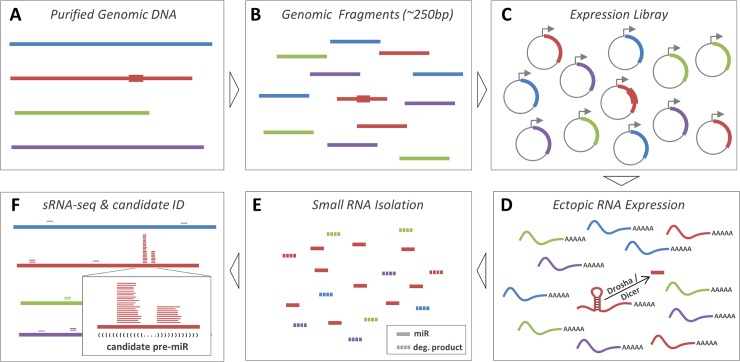
Overview of the miDGE (miRNA discovery by forced genomic expression) methodology.(A) Pools of purified viral genomes are subjected to (B) fragmentation via sonication or limited digest (average target size of fragments approx. 250 bp), followed by (C) cloning of subgenomic fragments to create an expression library. Thickened regions in A-C symbolize an unidentified pre-miRNA coding region present in one of the viral genomes. (D) After transient transfection, cloned subgenomic fragments are transcribed in cells, allowing processing of pre-miRNA hairpins to produce mature miRNAs. (E) Small RNAs purified from transfected cells will contain mature miRNAs as well as random degradation products produced from library transcripts. (F) To identify authentic miRNAs, small RNAs are sequenced and mapped back to viral genome pools. The majority of degradation products exhibit a random distribution, whereas miRNA products produce distinct pileups at pre-miRNA loci. Secondary structure prediction can then be used to identify characteristic pre-miRNA hairpin structures (indicated by bracket notation in F) at such loci. In this study, we used the miRDeep2 package to identify miRNA candidates.